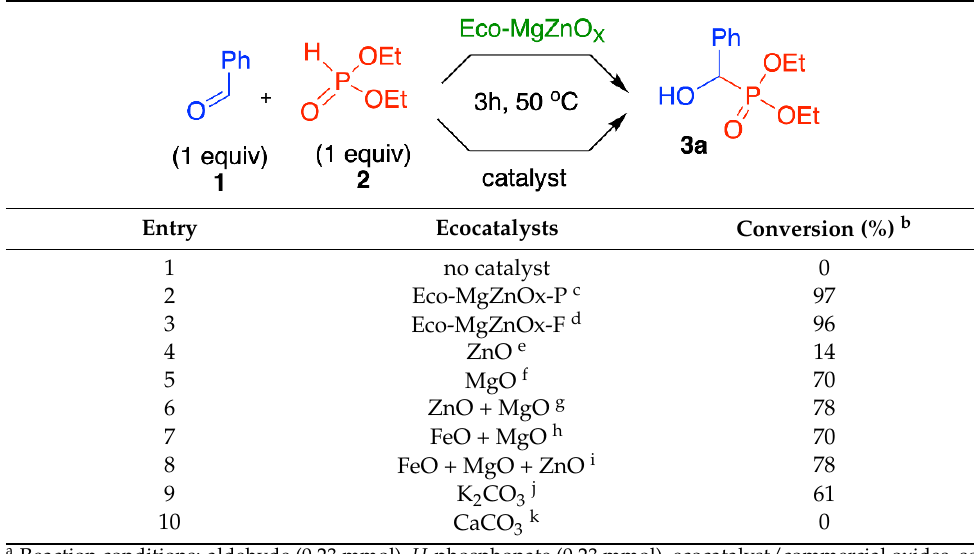
Table 2. Comparison of catalytic activity between Eco-MgZnOx and commercial oxides (catalyst) in the model reaction leading to diethyl-(1-hydroxyphenylmethyl) phosphonate ( 3a ) a .